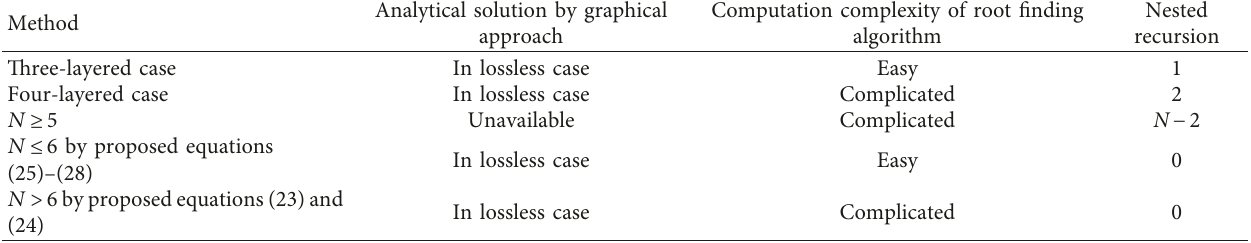
Figure 8: The electric component of trapped surface wave | E S layered